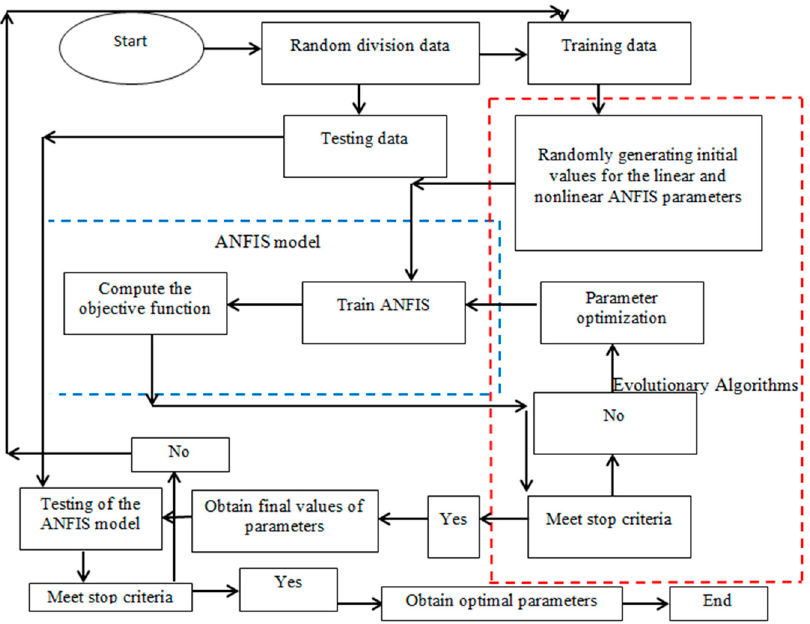
Figure 4. ANFIS and Evolutionary Algorithm [26].